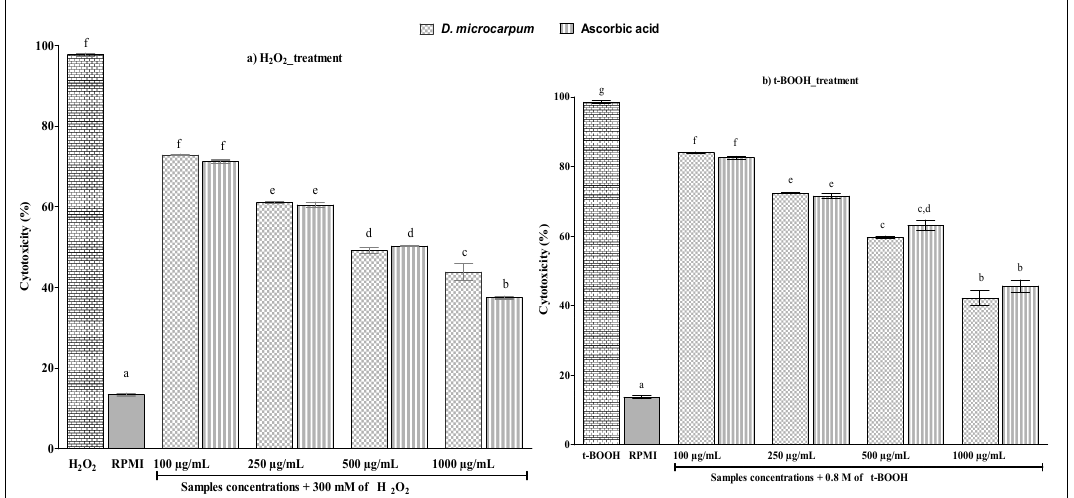
Figure 2. Cytoprotective effect of ethanol extract and ascorbic acid: ( a ) against hydrogen peroxide-induced human lymphocyte oxidative damage; ( b ) against tert-butyl hydroperoxide-induced human lymphocyte oxidative damage. Values are expressed as mean values ± standards deviation ( n = 3 independent experiments). a–g Values with different superscripted letters for each oxidant applied differ significantly ( p < 0.05) as determined by analysis of variance.